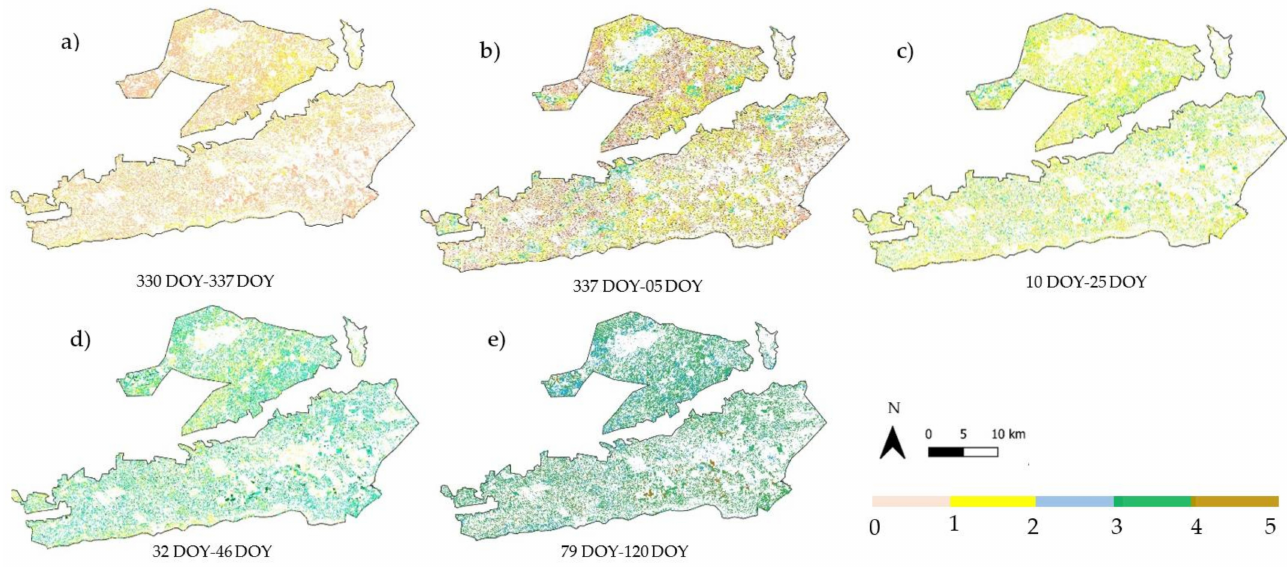
Figure 15. Maps of the five phenological stages of wheat for the TIP region deduced from Sentinel-2 (Model 3). The color bar represents the 0–1: germination, 1–2: tillering, 2–3: jointing, 3–4: heading, 4–5: maturity